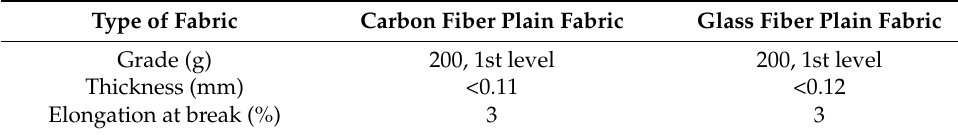
Table 2. Physical properties of carbon and glass fiber fabrics.